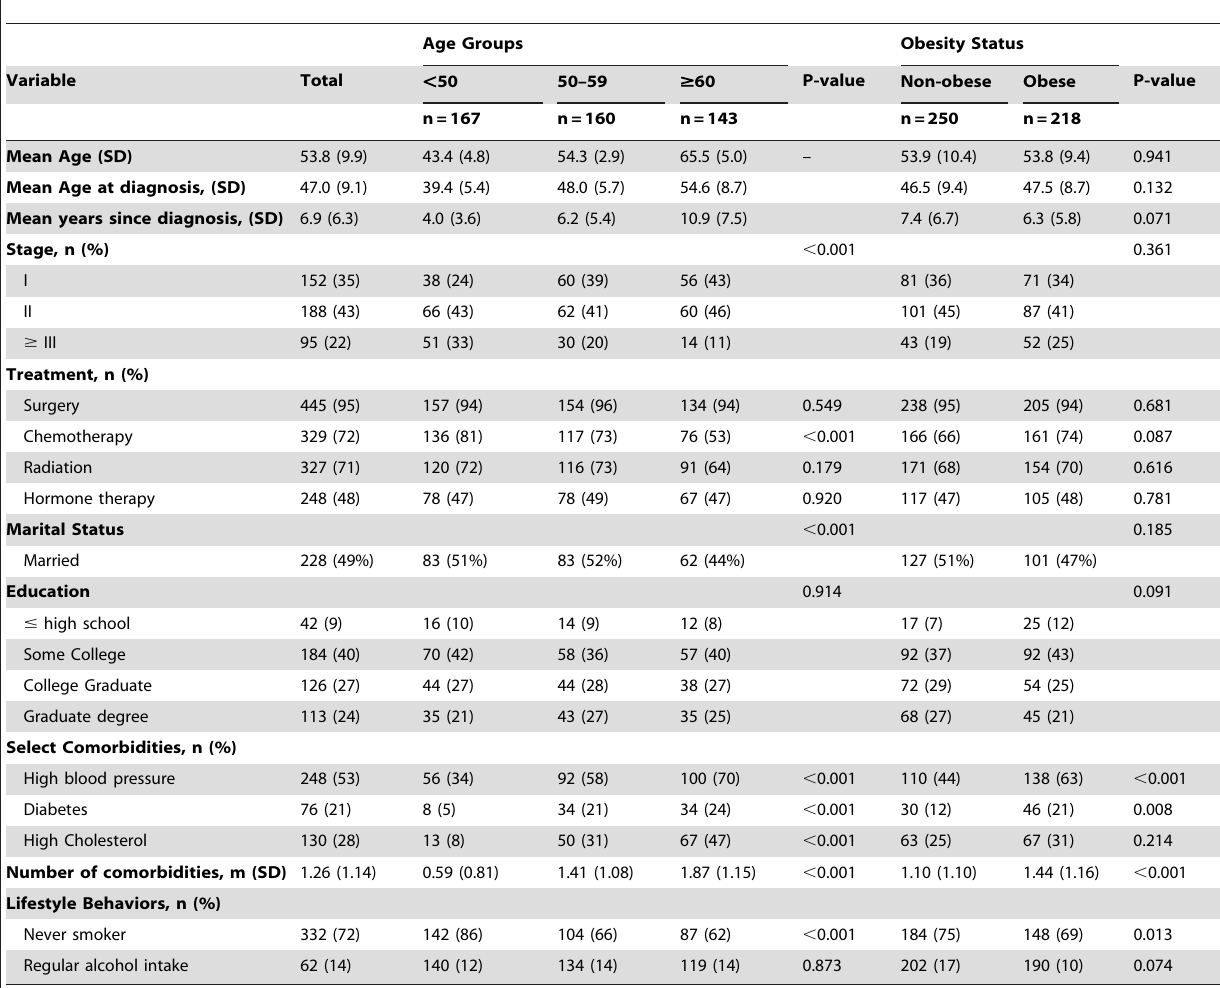
Table 1. Medical and demographic characteristics of AA breast cancer